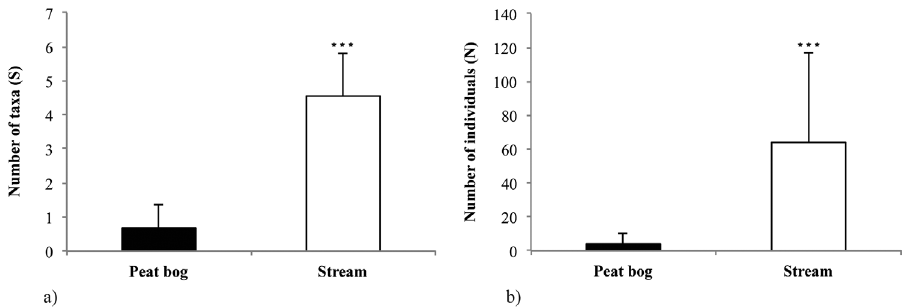
Figure 2. Mayfly taxa: a species richness (S) and b number of individuals (N) in the peat bog and adjacent stream (mean ± SD). The asterisk indicates significant difference between the habitats (Mann- Whitney U test, p < 0.001).